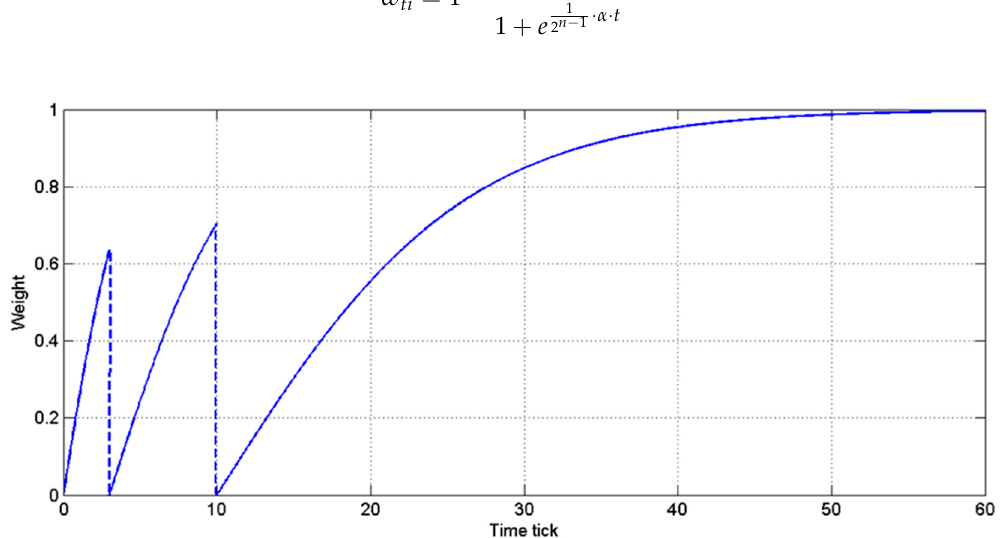
Figure 3. Example of the weight of a sensor node influenced by the actuator.